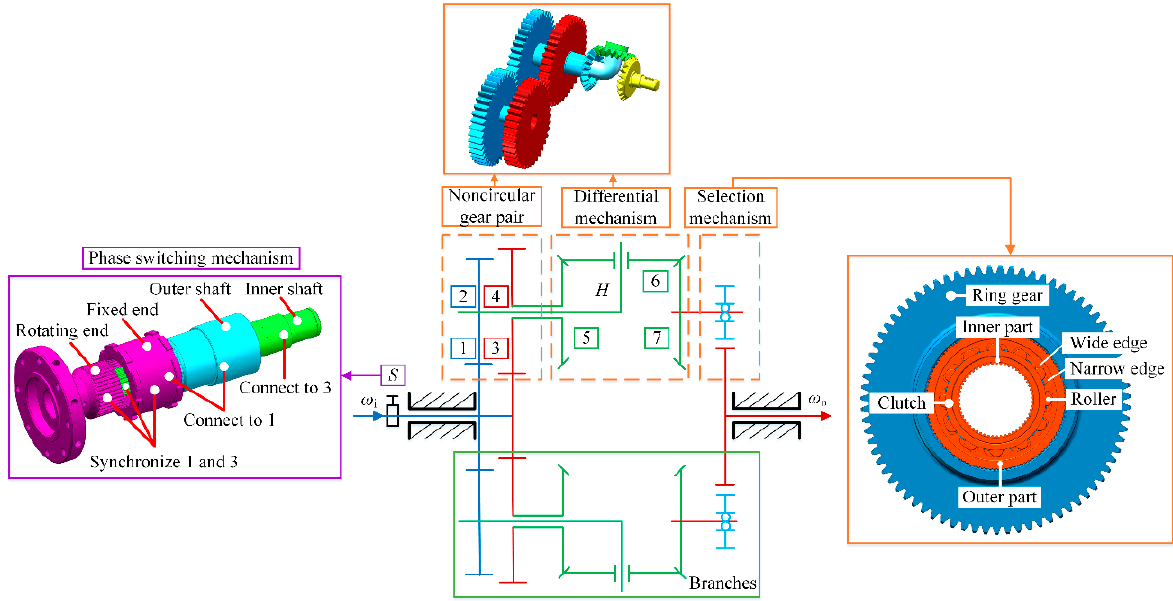
Figure 3. Transmission principle of class A.